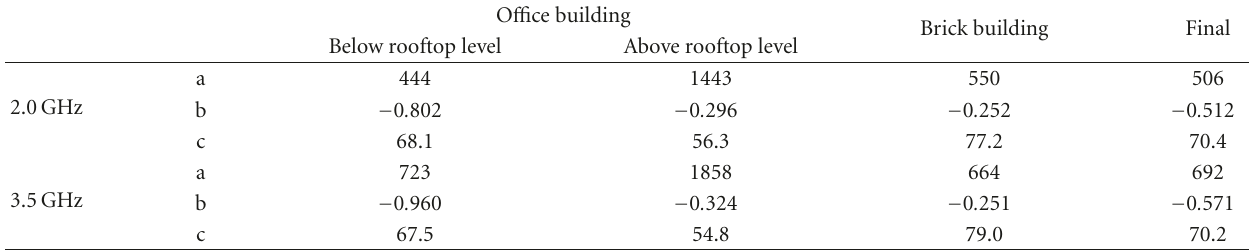
Table 1: Parameters of the penetration loss model for di ff erent environments and frequencies in an urban area.